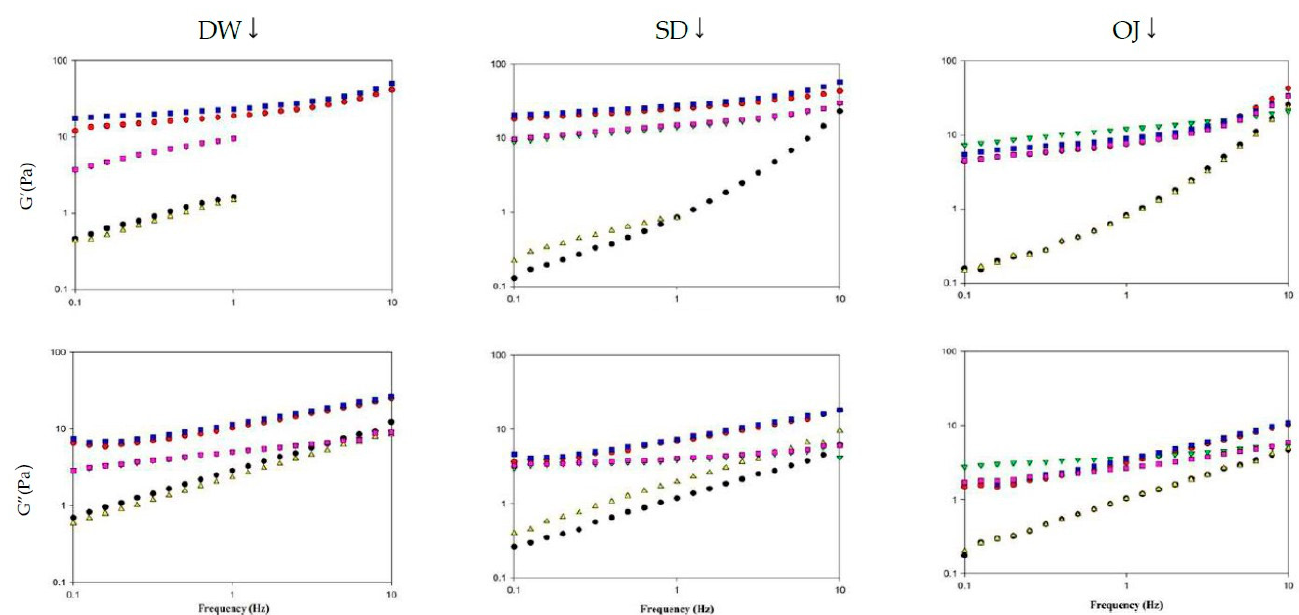
Figure 10. Frequency sweep of different thickened fluid matrices. TS: tapioca starch; HDP: hydroxypropyl distarch phosphate; XG: xanthan gum; 3m: 3 min; 6m: 6 min. ( • ) = TS-3m; ( • ) = HDP-3m; ( (cid:72) ) = XG-3m; ( (cid:78) ) = TS-6m; ( (cid:4) ) = HDP-6m; ( (cid:4) ) =